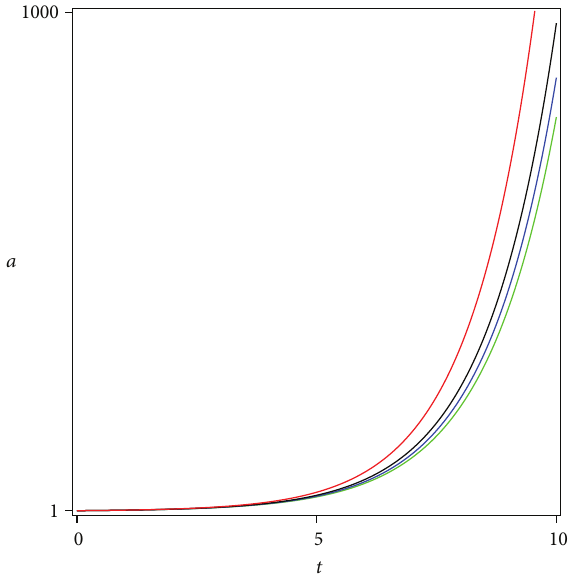
Figure 8: Energy density versus time for 𝐵 = 3 , 𝛼 = 0.9 , and 𝐴 = 1/3 . 𝑛 = 1 (green line), 𝑛 = 2 (blue line), 𝑛 = 3 (black line), 𝑛 = 4 (red